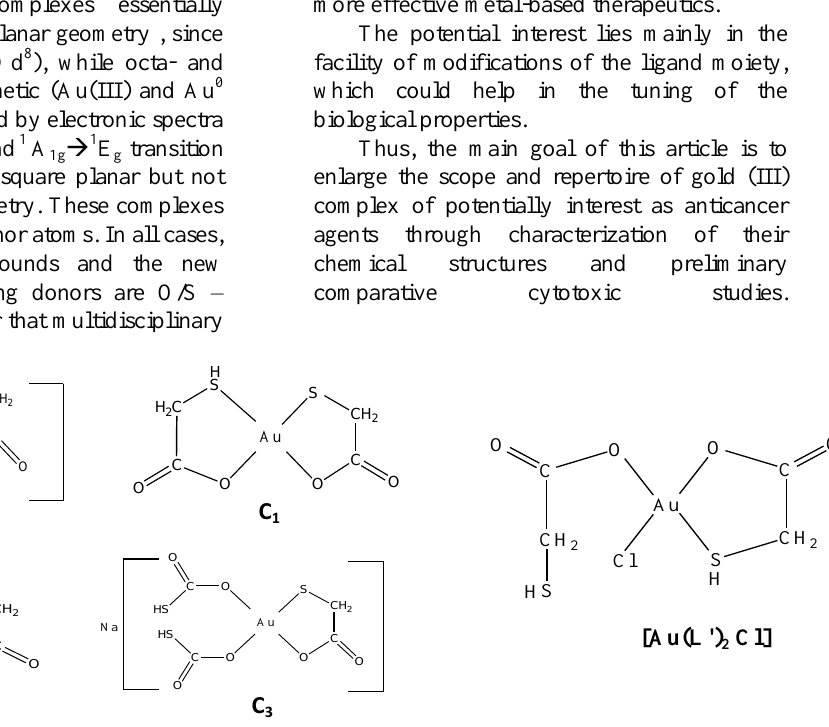
Figure (1) : The chemical structures of the previously synthesized complexes (C1-C4)(16) and the target complex of this article (Au(L') 2